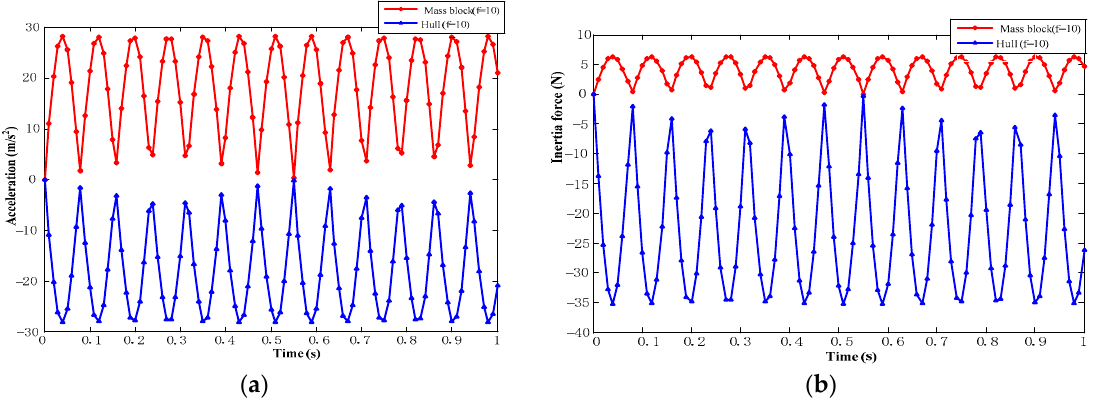
Figure 7. Acceleration and inertia force simulation diagram of mass block and base. ( a ) Acceleration diagram; ( b ) inertia force diagram.